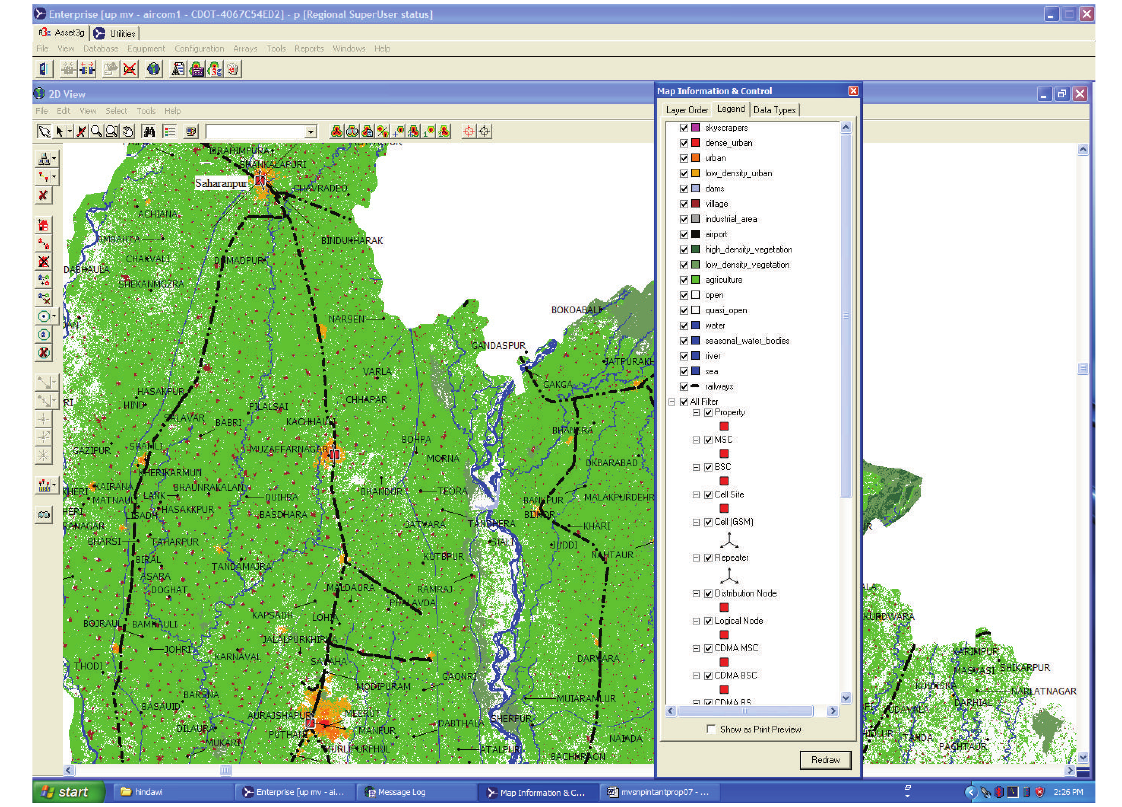
Figure 1: Clutter map of north Indian base